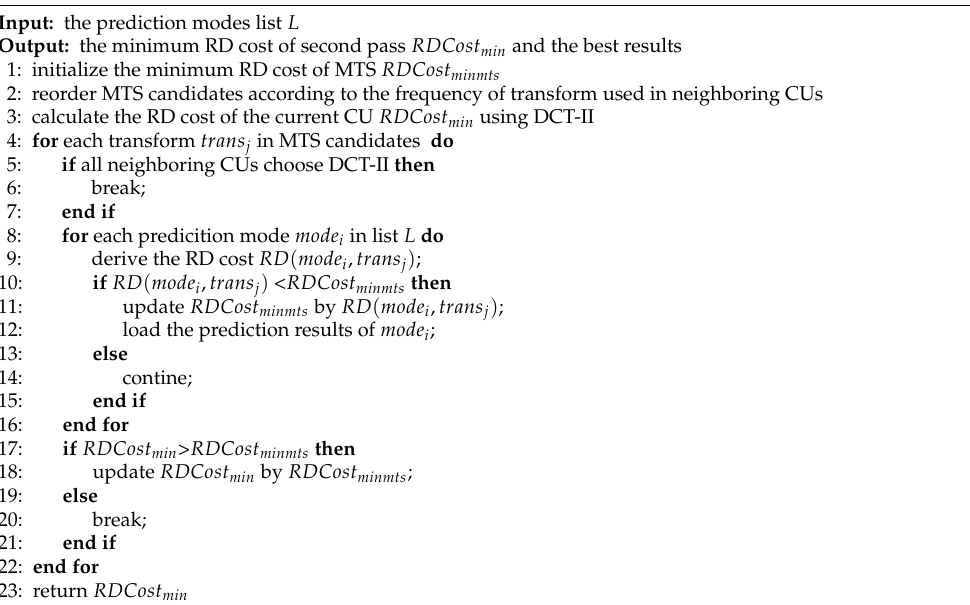
Algorithm 2 The proposed MTS early termination